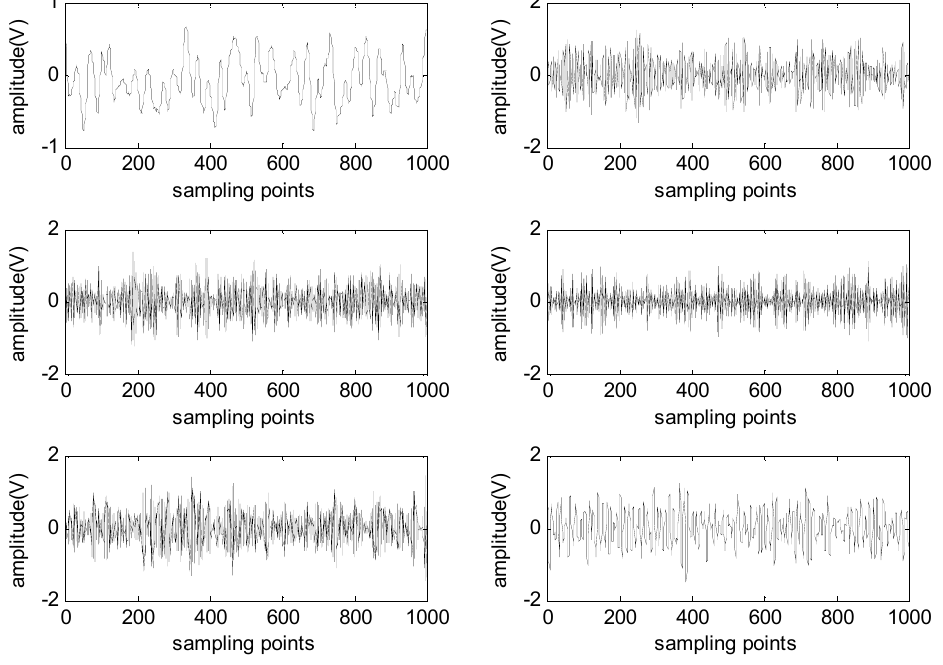
Figure 4. BLIMFs decomposed by the VMD method.